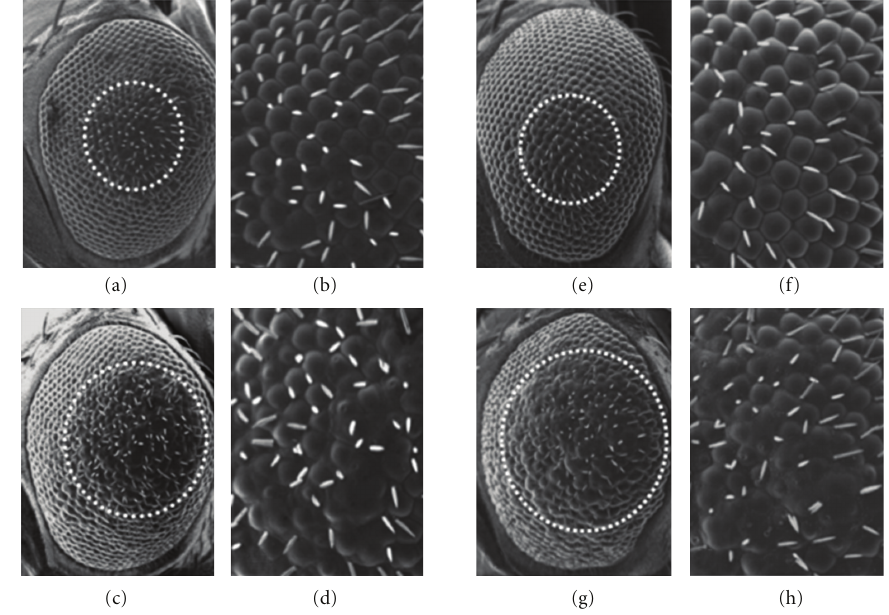
Figure 4: Suppression of compound eye degeneration by coexpression of α B-crystallin in the α -synuclein-expressing flies. Light microscope images of the adult compound eyes. (a, b) Transgenic flies coexpressing α -synuclein and α B-crystallin ( gmr-gal4/ + ; uas- α B-crystallin-HA/ + ; uas- α -synuclein/+). (c, d) Transgenic flies coexpressing α -synuclein and control LacZ protein ( gmr-gal4/ + ; uas-LacZ/ + ; uas- α -synuclein/+). (e, f) Control flies ( gmr-gal4/ + ; + ; +) . (g, h) Transgenic flies expressing α -synuclein ( gmr-gal4/+; uas- α -synuclein/+; +) . (a, c, e, g ) Magnification x 200. (b, d, f, h) Magnification x